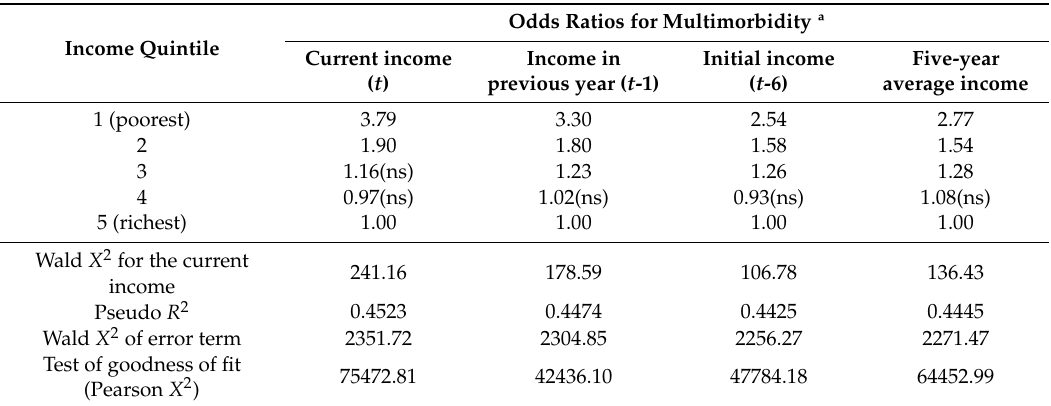
Table 3. Income at four di ff erent time points and